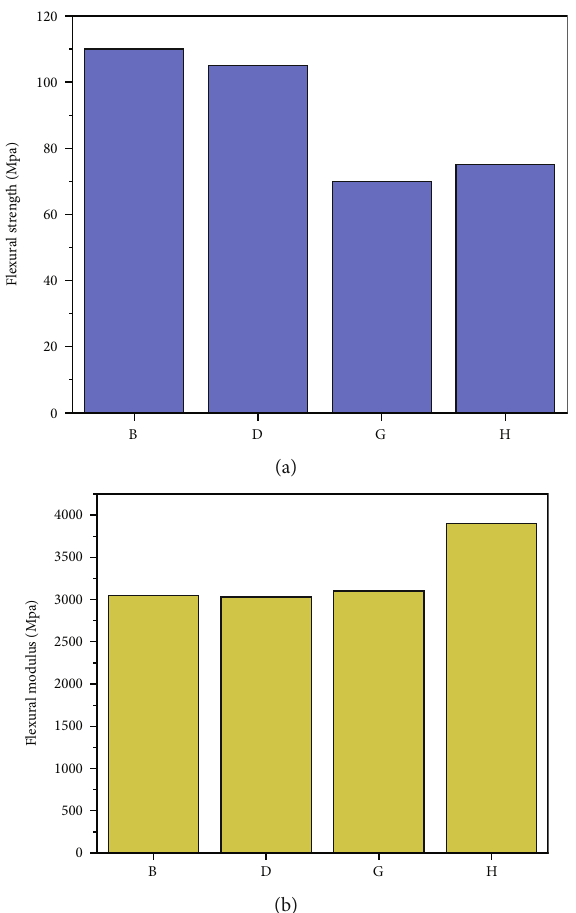
Figure 4: (a) Flexural strength and (b) modulus of neat vinyl ester reinforcement and pineapple leaf fi ber-vinyl ester reinforcement